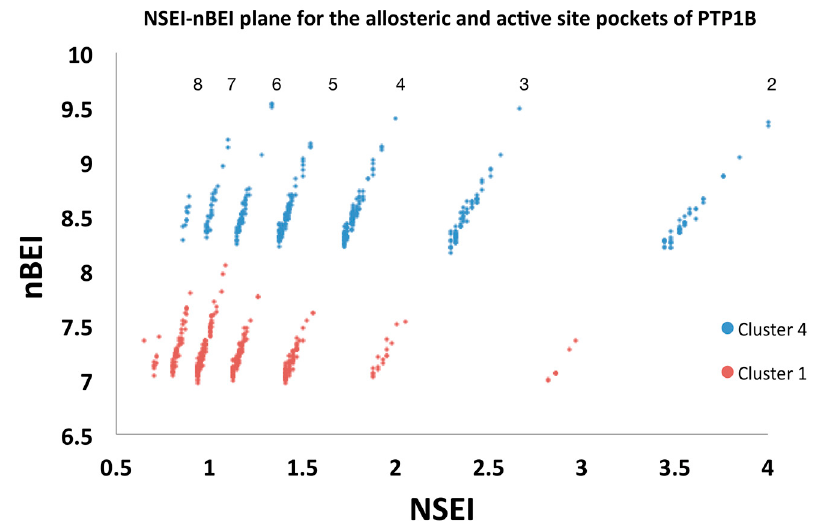
Figure 5. NSEI-nBEI plot for cluster 1 and 4. Selected ligands (top 500 ranked by ∆ G) from the targeted docking are shown. Red dots represent ligands from the active site cluster 1 and blue dots represent ligands from the allosteric site cluster 4. Each diagonal line of compounds represents a specific NPOL (number of N and O atoms in the compound) as given by the number above each diagonal line.